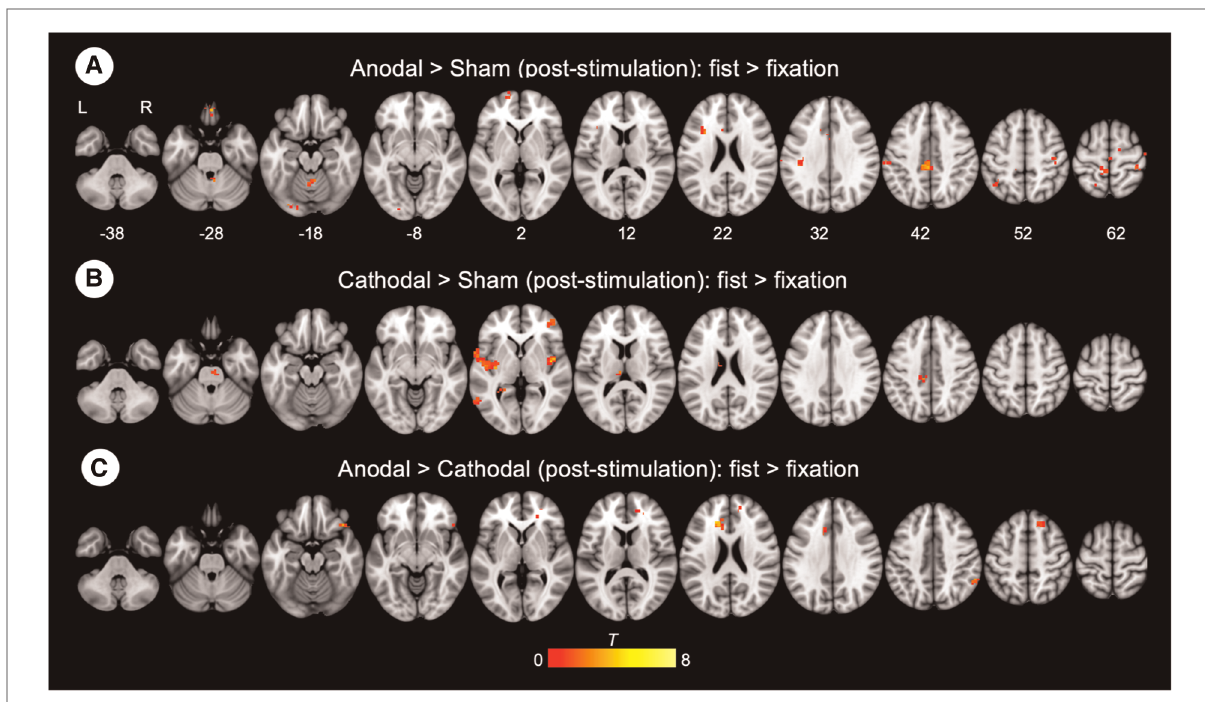
FIGURE 5 Whole-brain gPPI results for the left M1 during hand motor task. ( A, B, C ) Generalized psychophysiological interaction (gPPI) analysis: interaction of stimulation type x task condition ( fi st> fi xation) on M1 connectivity. R (right) and L (left) indicate image orientations for slices in axial planes. Reference positions are in MNI coordinates. All images are displayed with a statistical signi fi cance of p <0.005 at the voxel level and p <0.05 (ks>30) at a cluster level with false-discovery rate (FDR) correction.